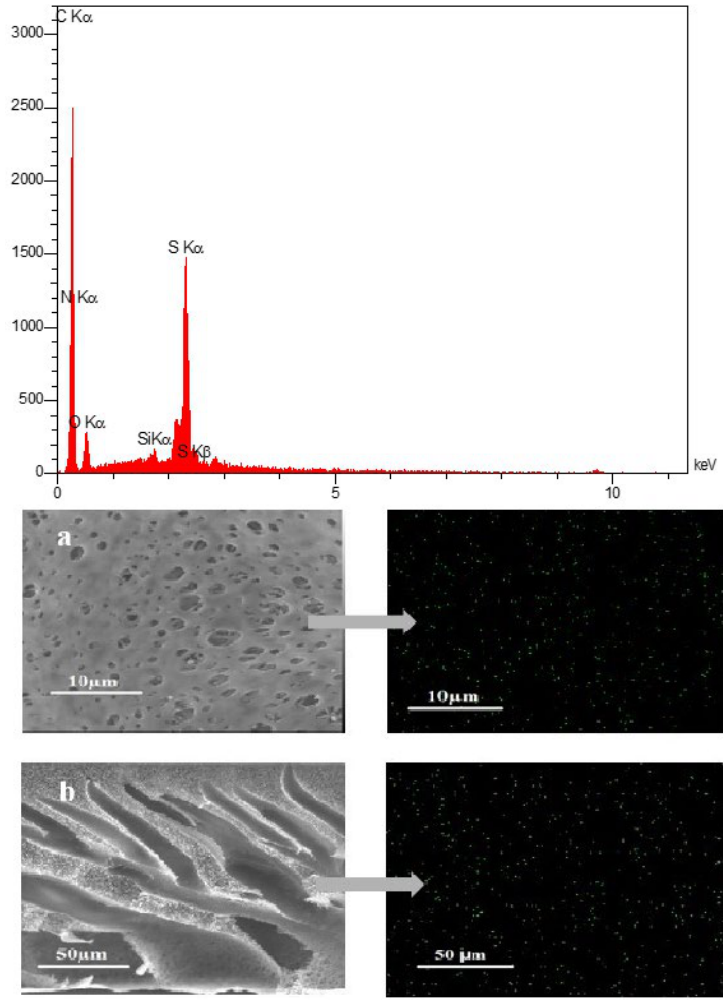
Fig. 4. The EDX result of PSf/SND (1.0 wt%) membrane (top) and Backscattered SEM of PSf/SND (1.0 wt%) membrane (a) surface, (b) cross-section